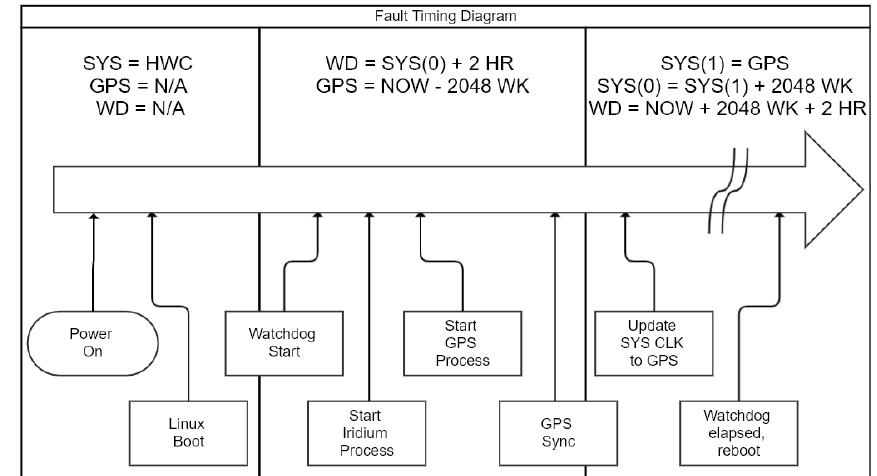
Figure 2. Diagram showing the process of updating the multiple clocks on an AAL-PIP. After the Linux OS finishes initialization, the AAL- PIP software sets the watchdog (WD) timer and spawns separate processes for communication and GPS synchronization. In this diagram, SYS(0) refers to the value of the system clock after boot, whereas SYS(1) is the system clock value after GPS sync. The fault occurs in block three, where the system clock SYS(1) is set to the erroneously offset GPS